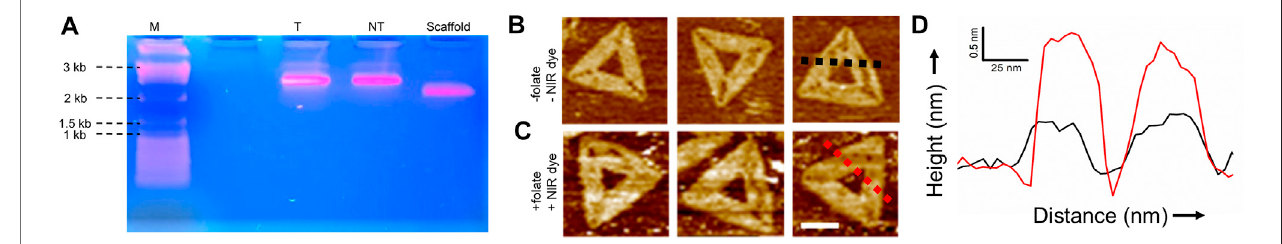
FIGURE 2 | Characterizations of trianglular DNA origami nanostructures: (A) Agarose gel electrophoresis of M13 scaffold strand (scaffold), targeted DNA origami (T), and nontargeted DNA origami (NT) showing the correct folding of DNA nanostructures. (B, C) AFM topography images of DNA origami structures without and with folateandNIRdyemodi fi edstrands,respectively.Scalebar:50 nm. (D) Heightpro fi lesofblacktracein fi gure (B) andredtracein fi gure (C) show ∼ 1 nmheightdifference due to presence of folate, and NIR dye functionalized strands.